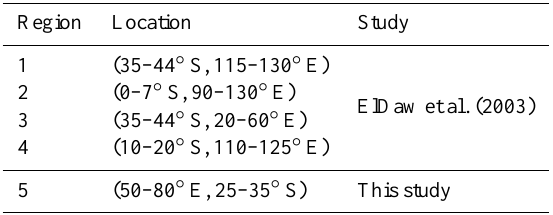
Table 2. Comparison between regions in the Indian Ocean used in ElDaw et al. (2003) and this study to predict the Nile flow.